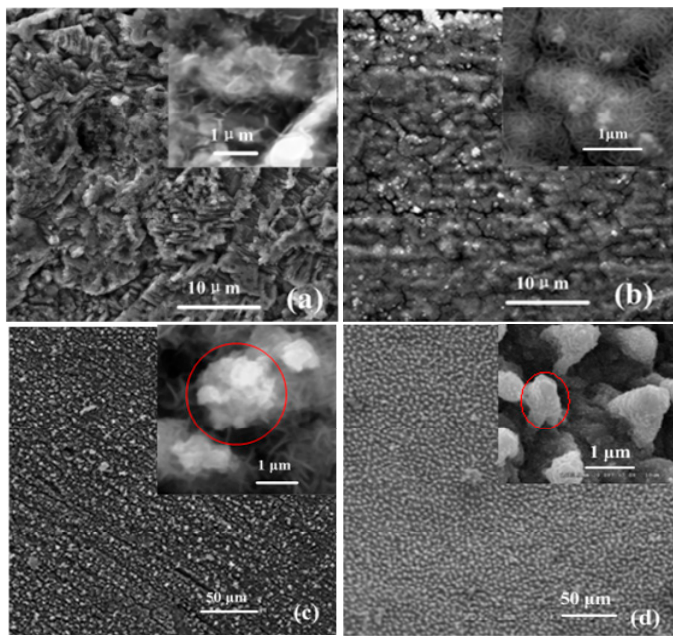
Figure 2. SEM images of nano-structures prepared at 70 °C in acidic solution for ( a ) 5 min; ( b ) 20 min, and ( c ) 30 min; ( d ) SEM image of the lotus leaf surface [35].